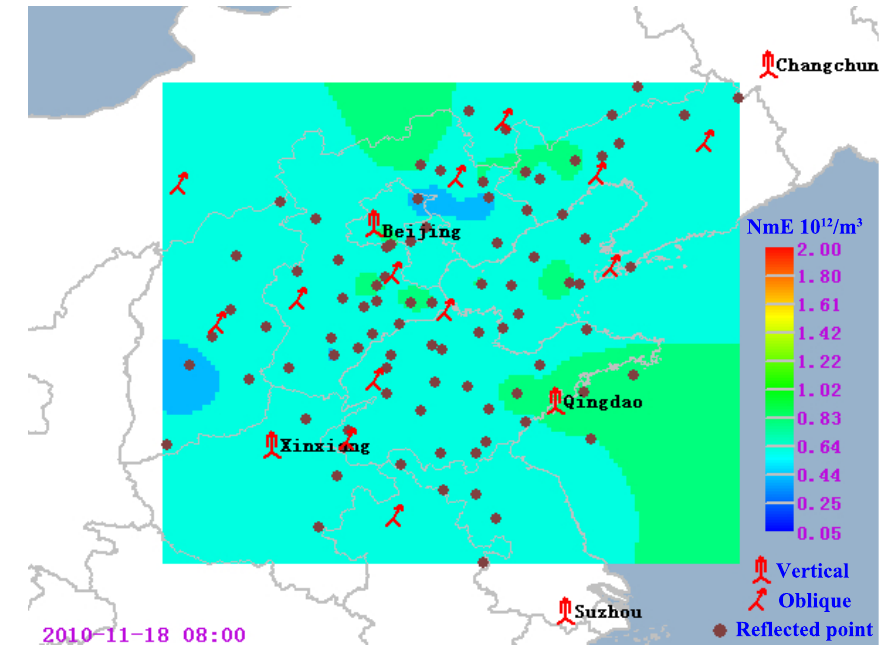
Fig. 7. Two-dimensional map of NmF2 (1.24 × 10 4 (foF2) 2 ) based on GBHIO network.